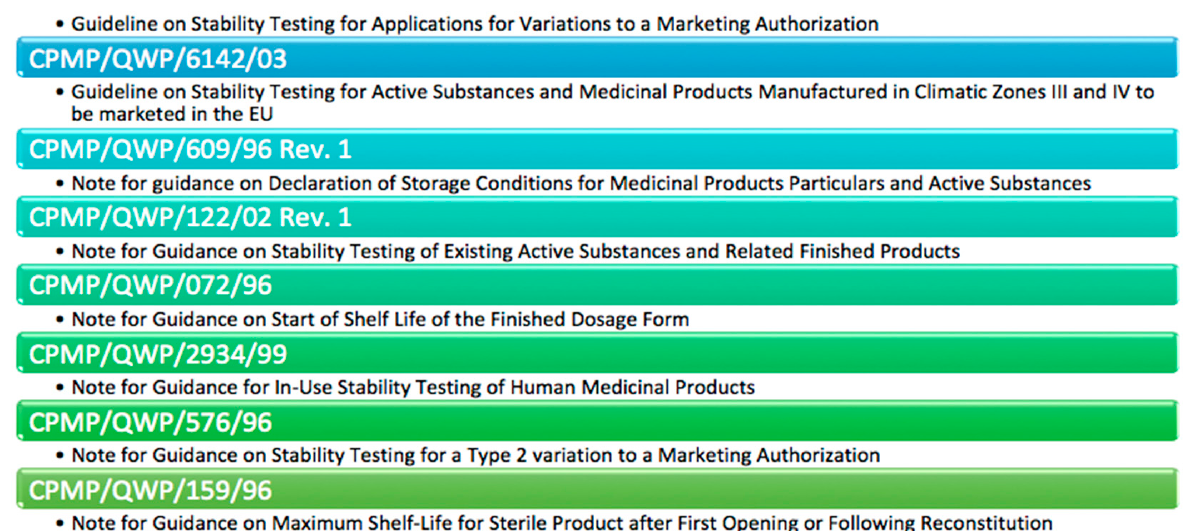
Figure 2. CPMP Guidelines. Modified from: [8].